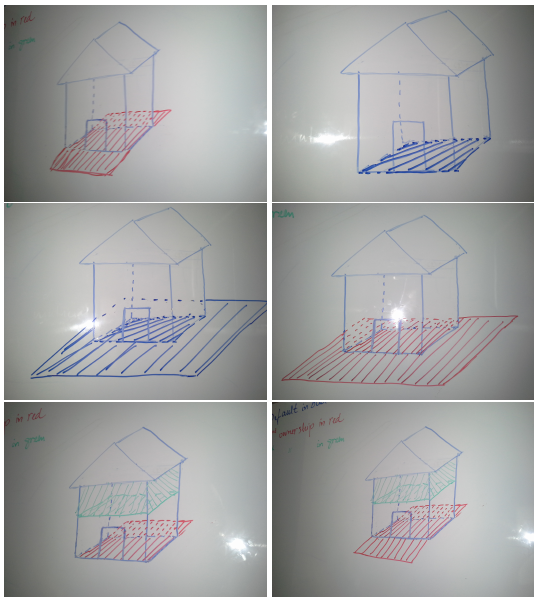
Figure 1: Property and Land Ownership Sketches - Top Left: Different owner for land and building, front and back garden, Top Right: same owner for land and building, no garden, Mid- dle left: same owner for land and building, surrounding garden, Middle right: different owner for land and building, surround- ing garden, Bottom left: different owner for upstairs, downstairs and land, back garden only, Bottom right: different owner for upstairs, downstairs and land, front and back garden